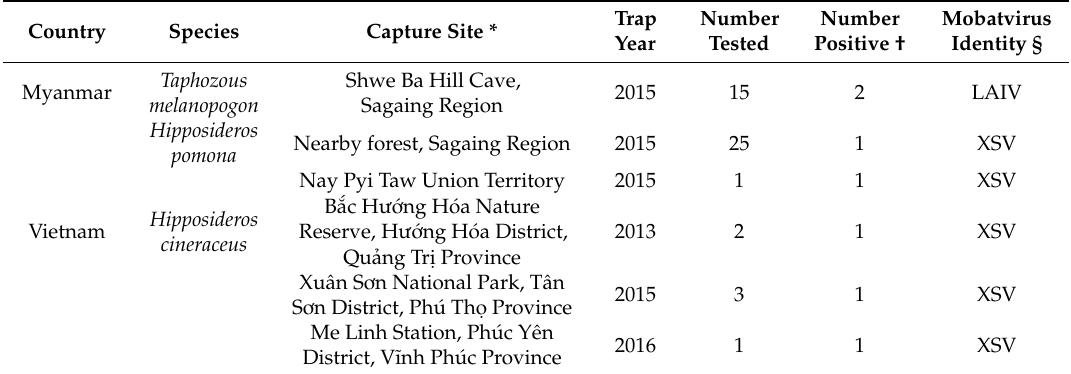
Table 2. RT-PCR detection of mobatvirus RNA in the lung tissues of bats captured in Myanmar and